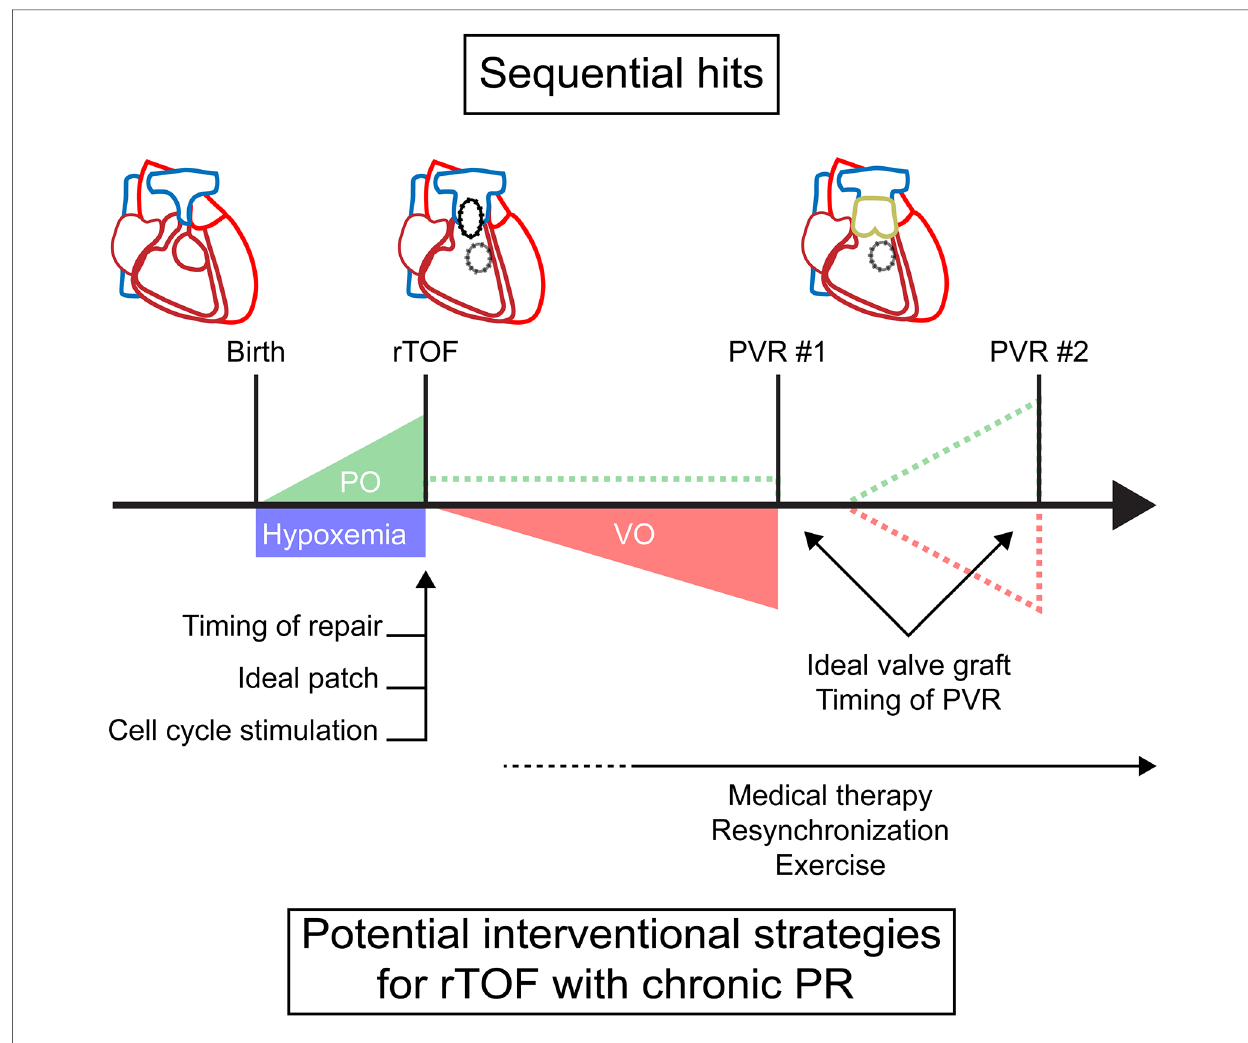
FIGURE 1 A timeline of sequential loading in tetralogy of Fallot with timing of potential interventions. Dashed lines represent potential residual or recurrent overload. PO, pressure overload; PR, pulmonary regurgitation; PVR, pulmonary valve replacement; rTOF, repaired tetralogy of Fallot; VO, volume